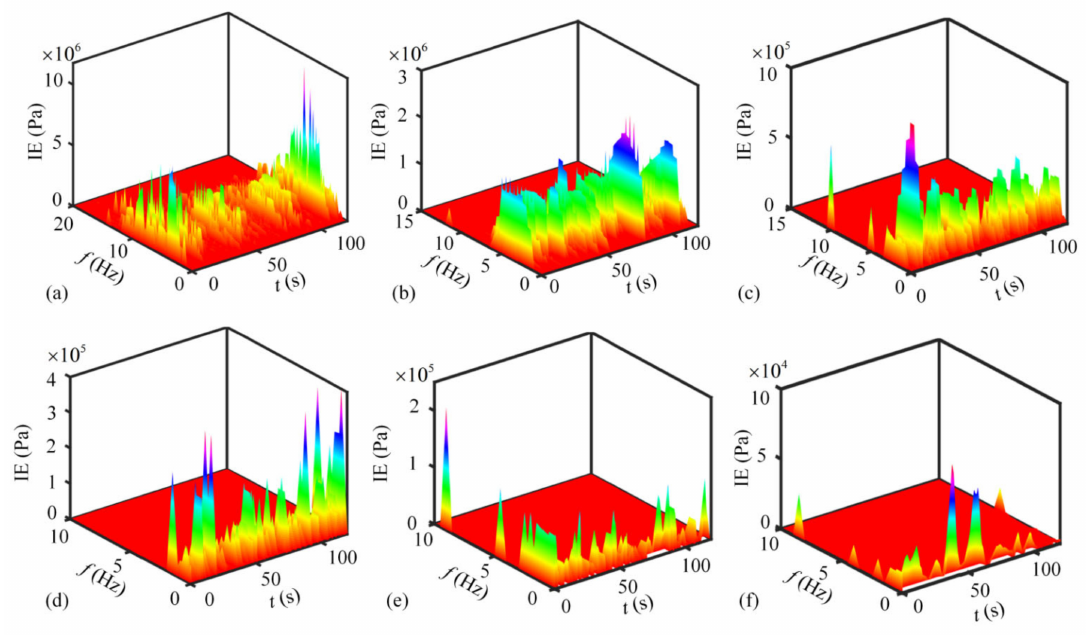
Figure 9. Hilbert spectrum of IMF component at bottom plate x / L = 0.025 for TP4 at k = 0.0403. ( a ) The Hilbert spectrum of IMF 1; ( b ) The Hilbert spectrum of IMF 2; ( c ) The Hilbert spectrum of IMF 3; ( d ) The Hilbert spectrum of IMF 4; ( e ) The Hilbert spectrum of IMF 5; ( f ) The Hilbert spectrum of IMF